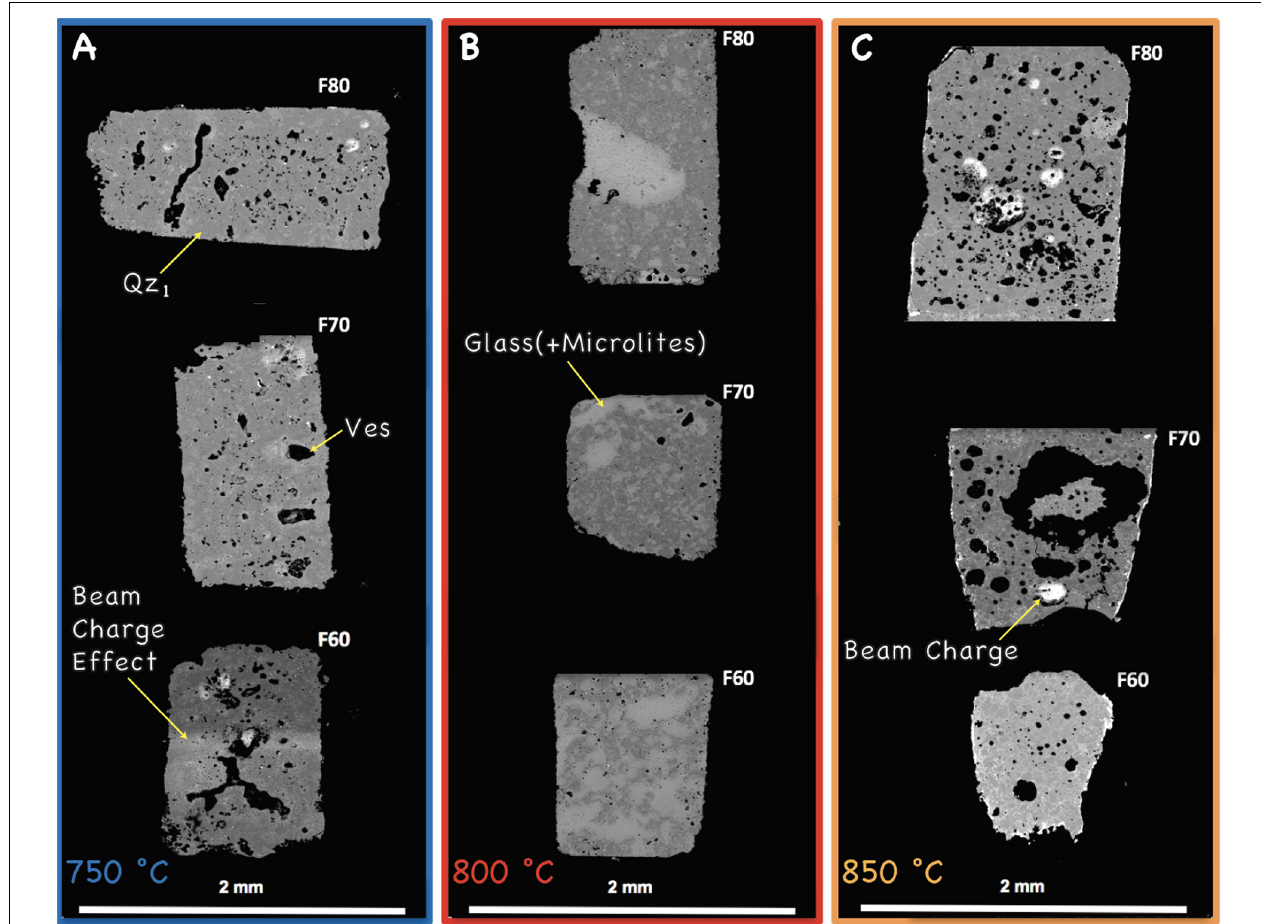
FIGURE 2 | FEG-probe-based BSE images of peripheral sections of all crystal-bearing samples from experiments at: (A) 750, (B) 800, and (C) 850 ◦ C. Acronyms are: Qz 1 = pre-existing quartz (dark gray); Ves = vesicle (black objects, sometimes filled with whitish material that produces electron charging); Glass = residual glass (least dark gray phase) that can be populated with